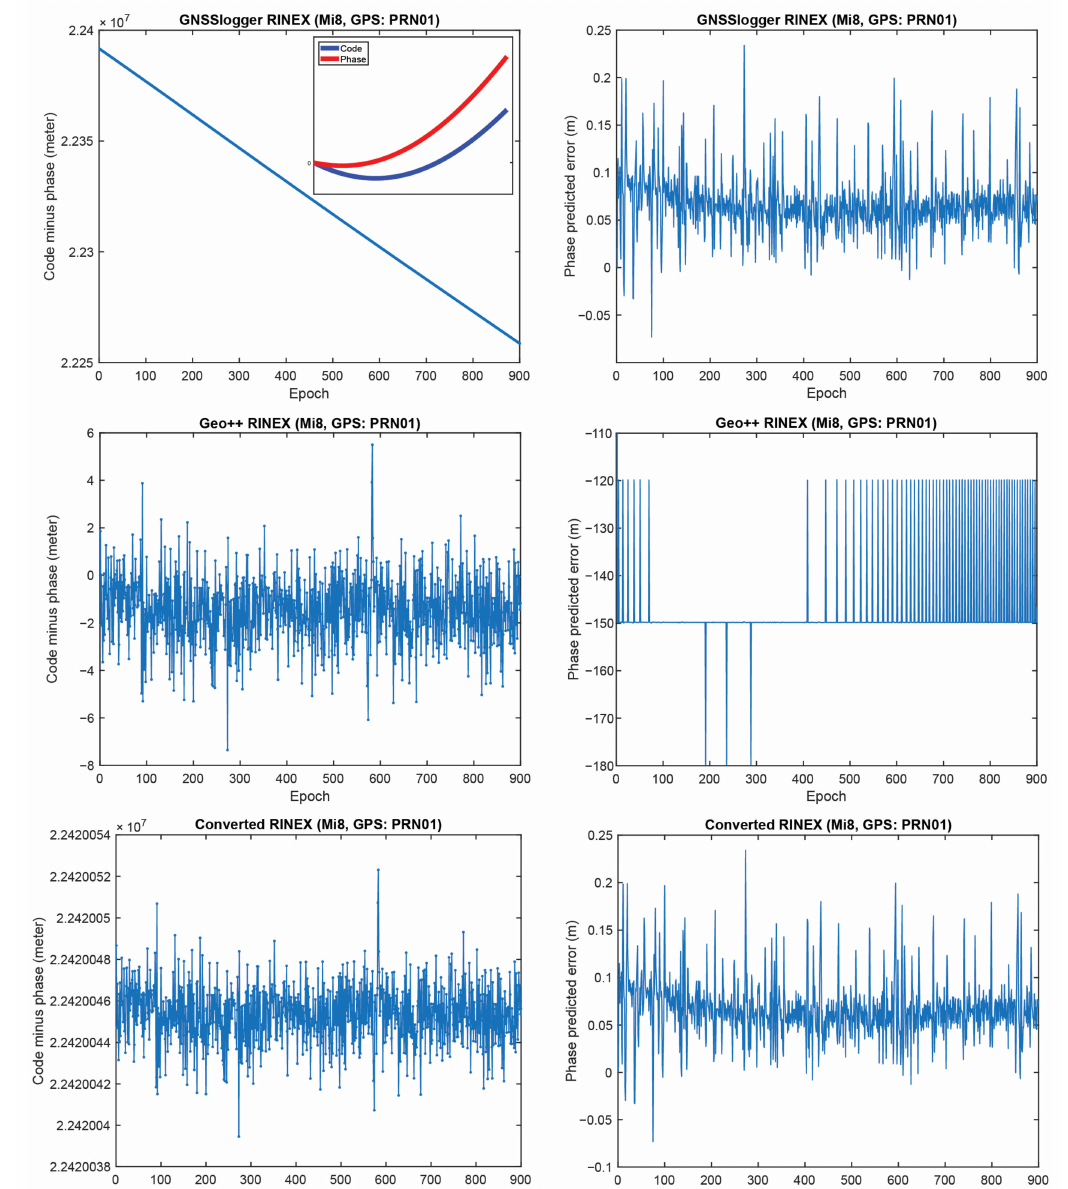
Figure 5. CMP ( left ) and carrier-phase predicted error ( right ) for GPS PRNs 01 (Xiaomi